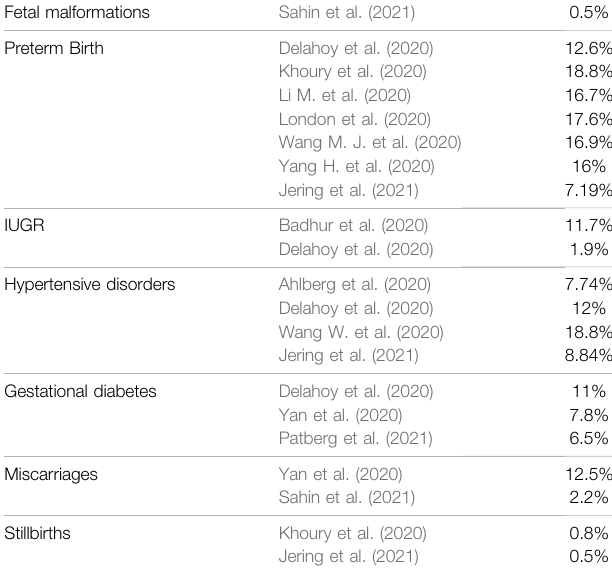
TABLE 1 | Pregnancy outcomes associated to SARS-CoV-2 infection and respective